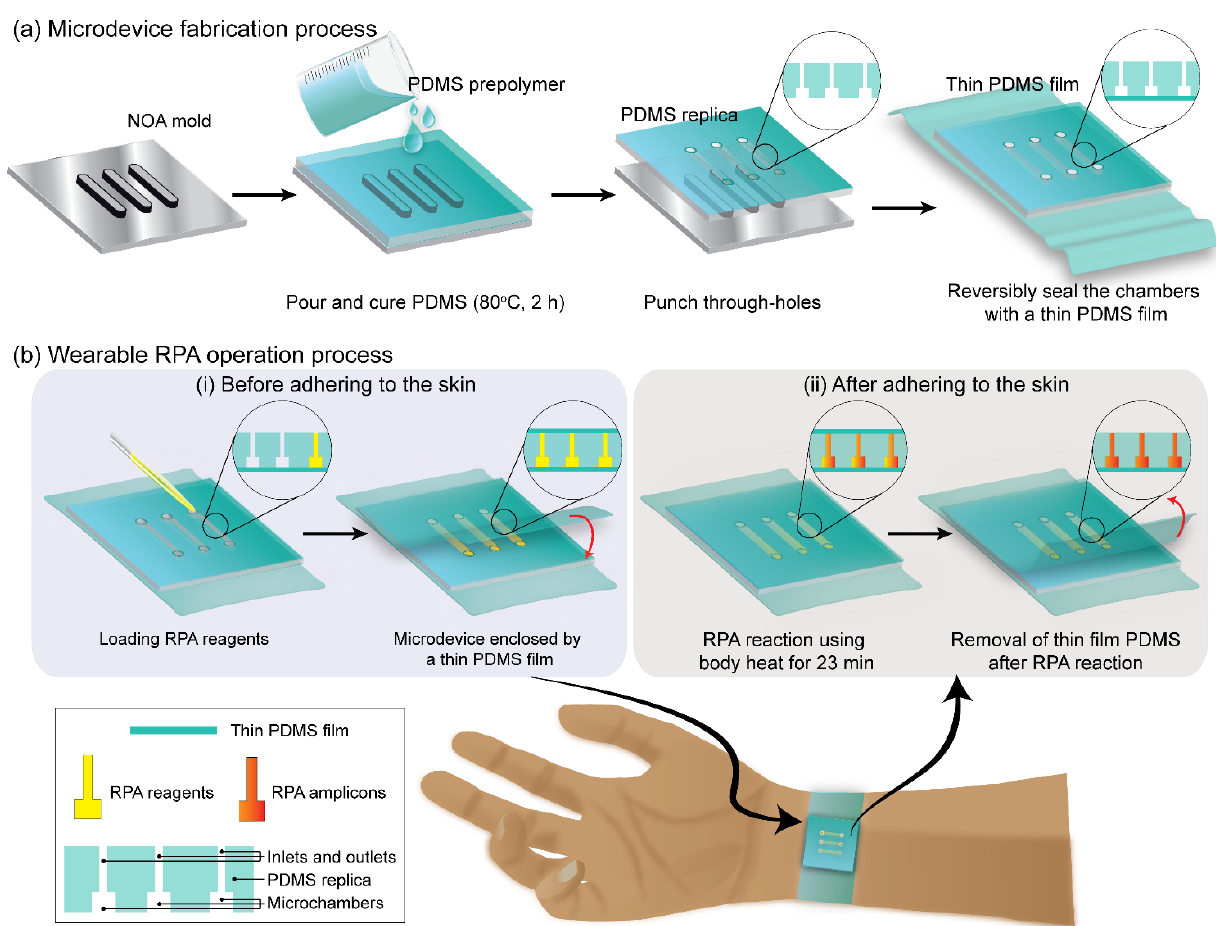
Figure 1. ( a ) Schematic illustration showing the fabrication of a wearable PDMS microdevice. ( b ) Schematic illustration showing the operation of a wearable PDMS microdevice.